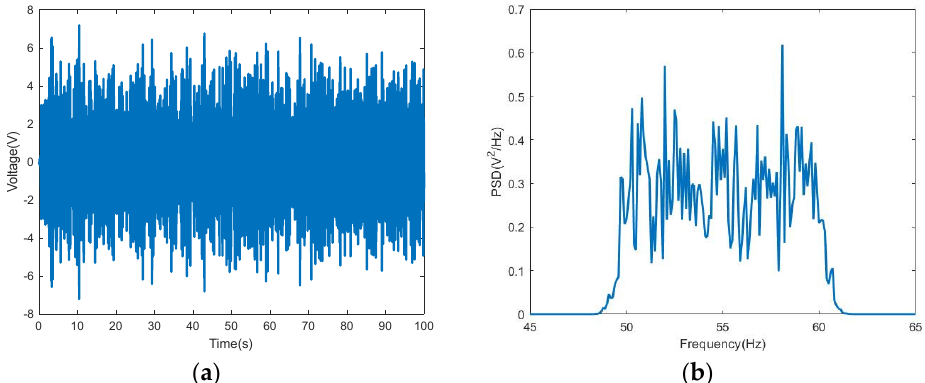
Figure 5. The narrow-band random white-noise signal. ( a ) Time-series signal. It is used as the input voltage signal of the actuator that applies force on the vibration system, where 1 V represents 12.3 N. ( b ) Power-spectrum density (PSD).